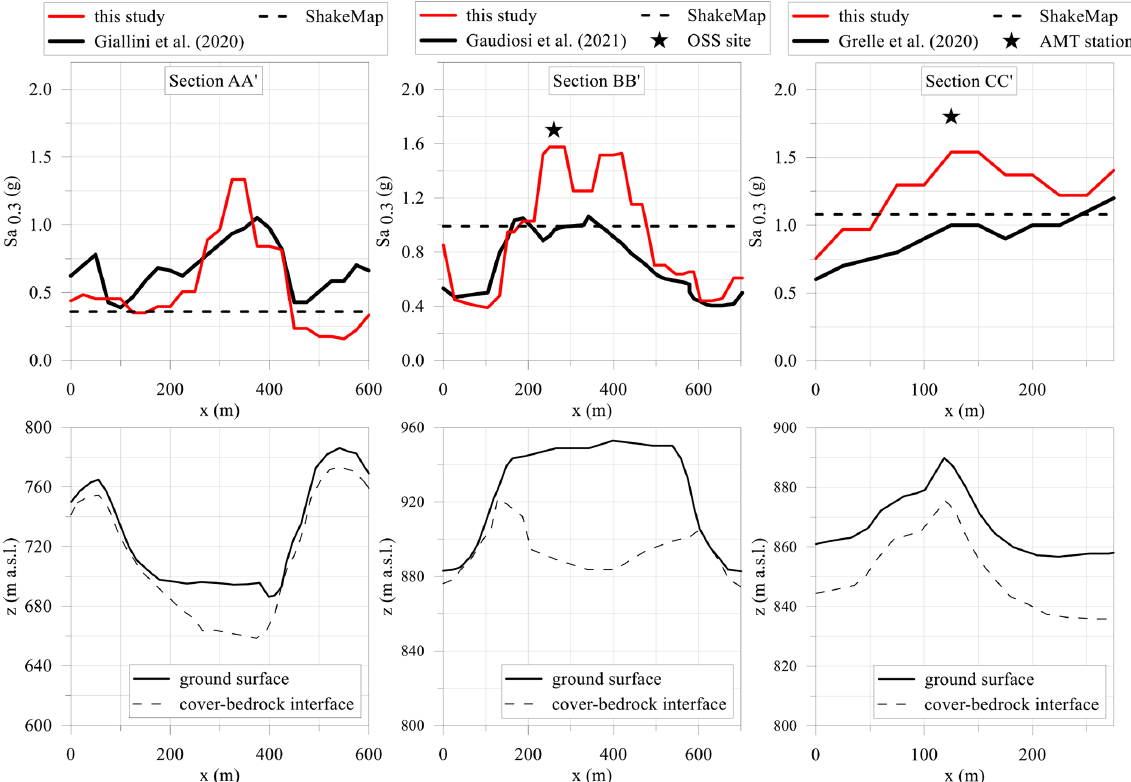
Figure 10. Profiles of Sa 0 . 3 (top) for the central Italy earthquake that occurred on 24 August 2016 and simplified subsoil sections (bottom) of Arquata del Tronto (section AA’) and Amatrice (section BB’ and section CC’). Cross sections’ locations are in Fig. 9. Sa 0 . 3 profiles and geological information retrieved and modified after Gaudiosi et al. (2021), Giallini et al. (2020), Grelle et al. (2020), and ShakeMap (2021). The black stars indicate values recorded at the OSS site and AMT station (for details, see the